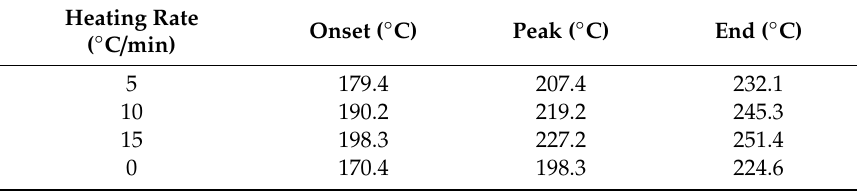
Table 1. The characteristic temperatures at various heating rates of